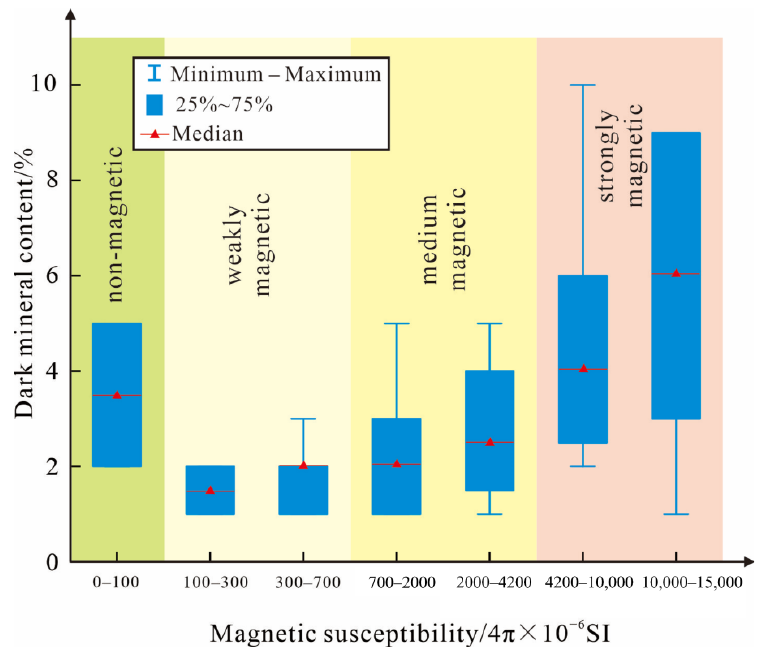
Figure 7. Plot of magnetic susceptibility versus dark mineral content. Note: According to the mag- netic susceptibility value, we divided the data into seven ranges and made a boxplot. The median and box data in the figure reflect a positive correlation between dark mineral content and magnetic susceptibility.